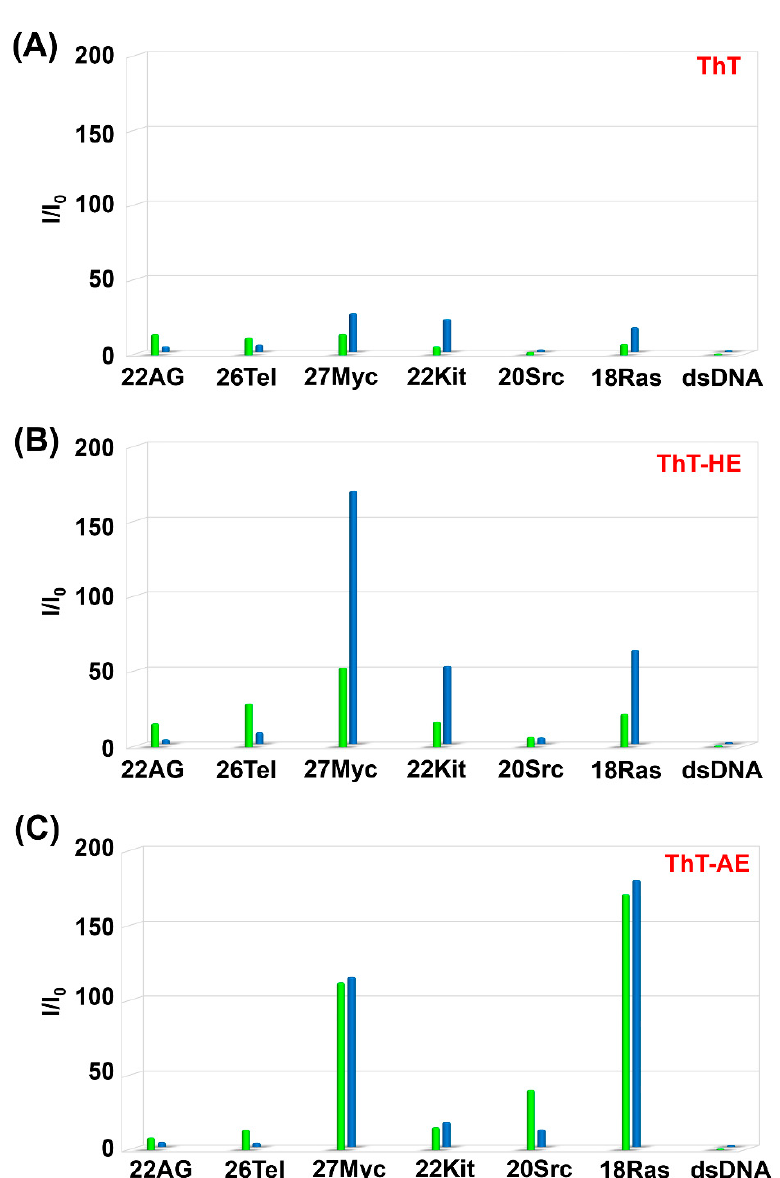
Figure 3. Relative fluorescence intensities (I/I 0 ) of ( A ) ThT, ( B ) ThT-HE, and ( C ) ThT-AE with each oligonucleotide in PBS140KM (green) and PBS153NM (blue). Here, I/I 0 is the ratio of the intensities of the fluorescence emitted upon the binding of the dye (3 μ M) to the oligonucleotide (15 μ M) and dsDNA (15 μ M; duplex concentration), respectively, in the same buffer. All samples were excited at 415 nm and the emissions were monitored at 485 nm. Table 1. Synthetic oligonucleotides used in this study. Conformation Oligonucleotide Sequence